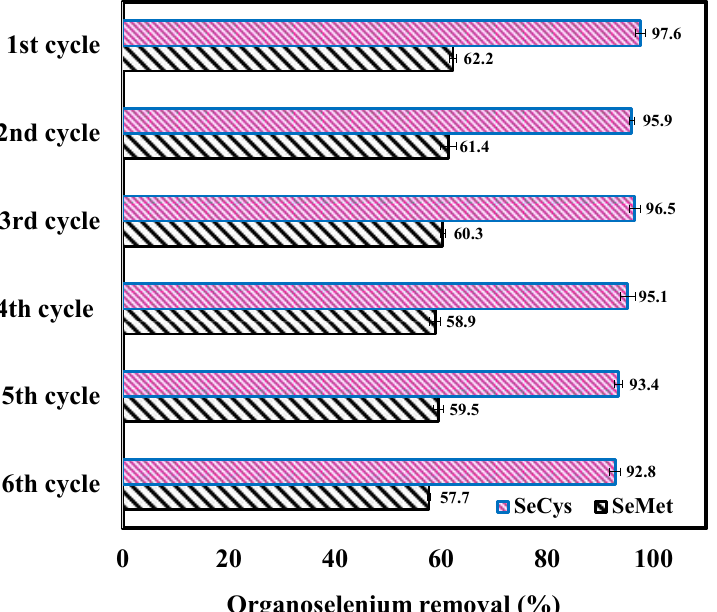
Figure 12. Organoselenium removal using regenerated nZVI/GAC in six treatment cycles. Initial concentration of 0.5 mg/L, 3 g/L, pH 7.0 at 25 °C for 6 h.